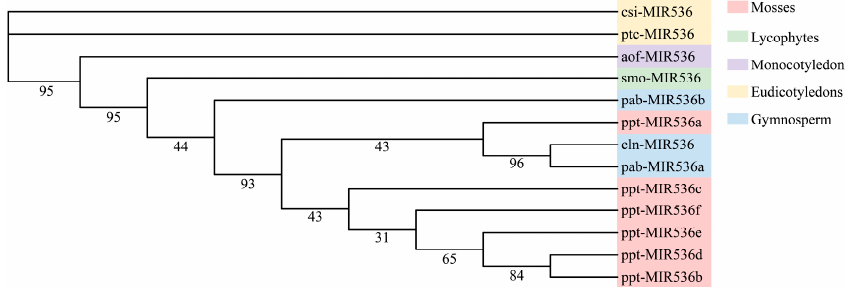
Figure 5. Phylogenetic tree of pre-miR536 in mosses, lycophytes, monocotyledons, eydicotyledons, and gymnosperms obtained from the IQ-TREE using the maximum likelihood method with 1000 bootstrap replicates. Labels: pab— P . abies ; cln— C. lanceolata ; smo— Selaginella moellendorffii ; csi— Citrus sinensis ; ppt— Physcomitrella patens ; aof— Asparagus officinalis .